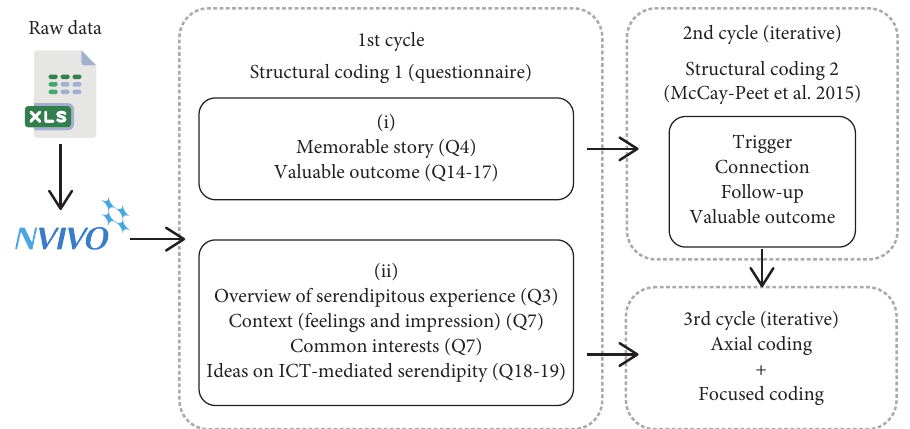
Figure 2: The process and methods of qualitative coding.